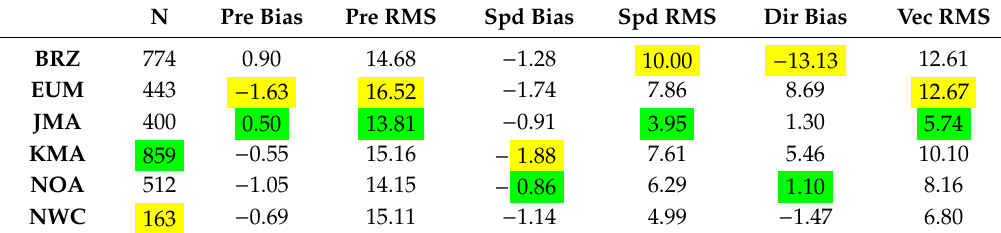
Table 3. Experiment 1: Comparison of AMVs, with CQI >= 50%, to radiosonde winds within 150 km. (N = Number of Matches; Pre Bias = Pressure Bias; Pre RMS = Pressure Root Mean Square Error; Spd Bias = Wind Speed Bias; Spd RMS = Wind Speed Root Mean Square Error; Dir Bias = Wind Direction Bias; Vec RMS = Wind Vector Root Mean Square Error). The extremes for each category are highlighted; in yellow, the worst value, and in green, the best value.